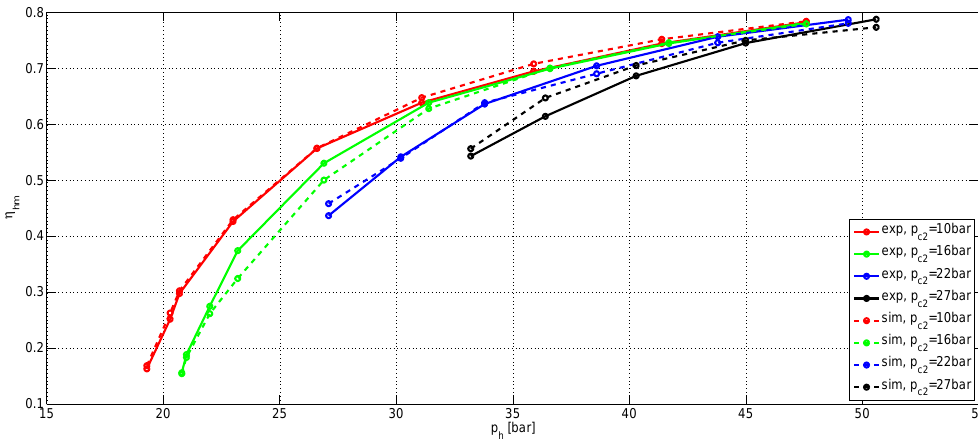
Figure 14: The simulated and experimental hydro-mechanical